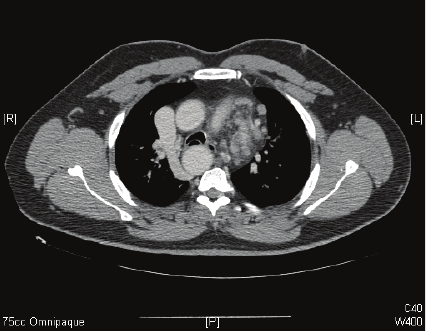
Figure 1: Axial CT scan with contrast at the level of T2, showing an enlarged thyroid gland, larger on the left, with tracheal deviation and inhomogeneous enhancement.